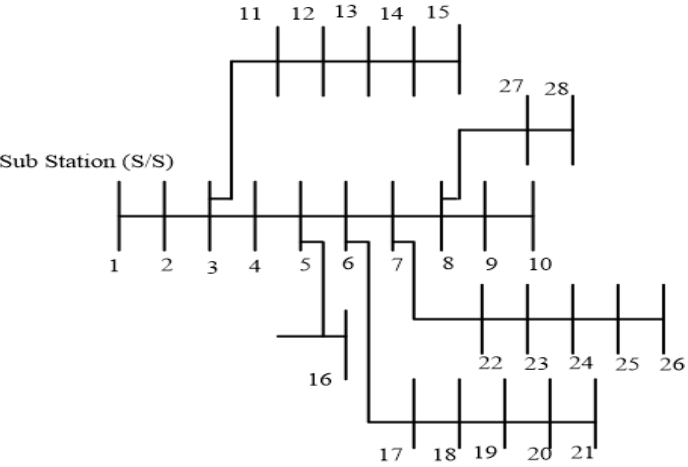
Figure 8. 28 Indian real test system single line diagram.